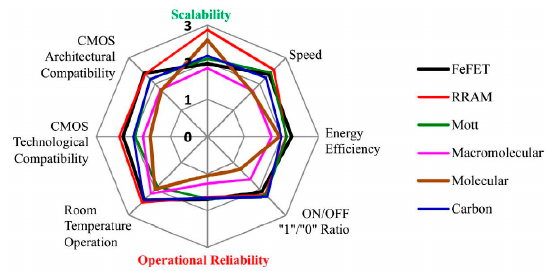
Figure 6. As compared to other devices, RRAM is showing better performance. (Reproduced from [Solid-State Electron. 2016, 125, 25–38], with the permission of Elsevier Publishing [2].)